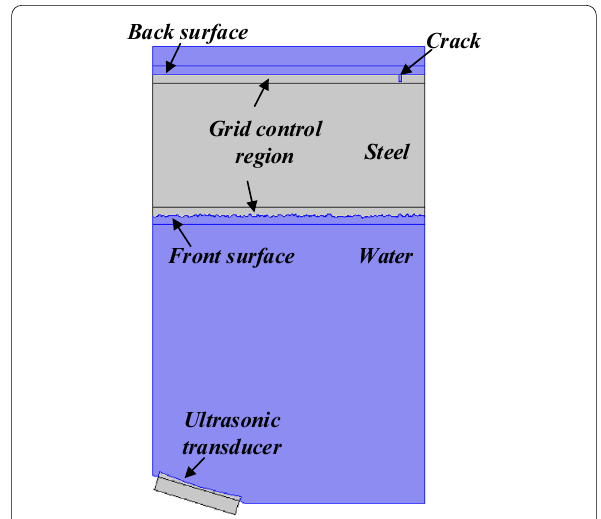
Figure 3 Two-dimensional simulation model for ultrasonic inspection of micro-crack with rough